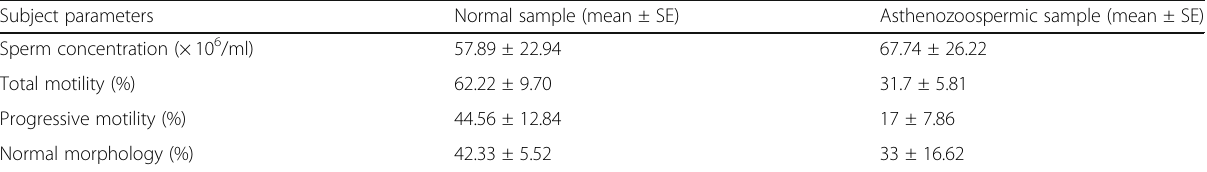
Table 1 Basic data of normal samples ( n = 8) and asthenozoospermic samples ( n = 9)